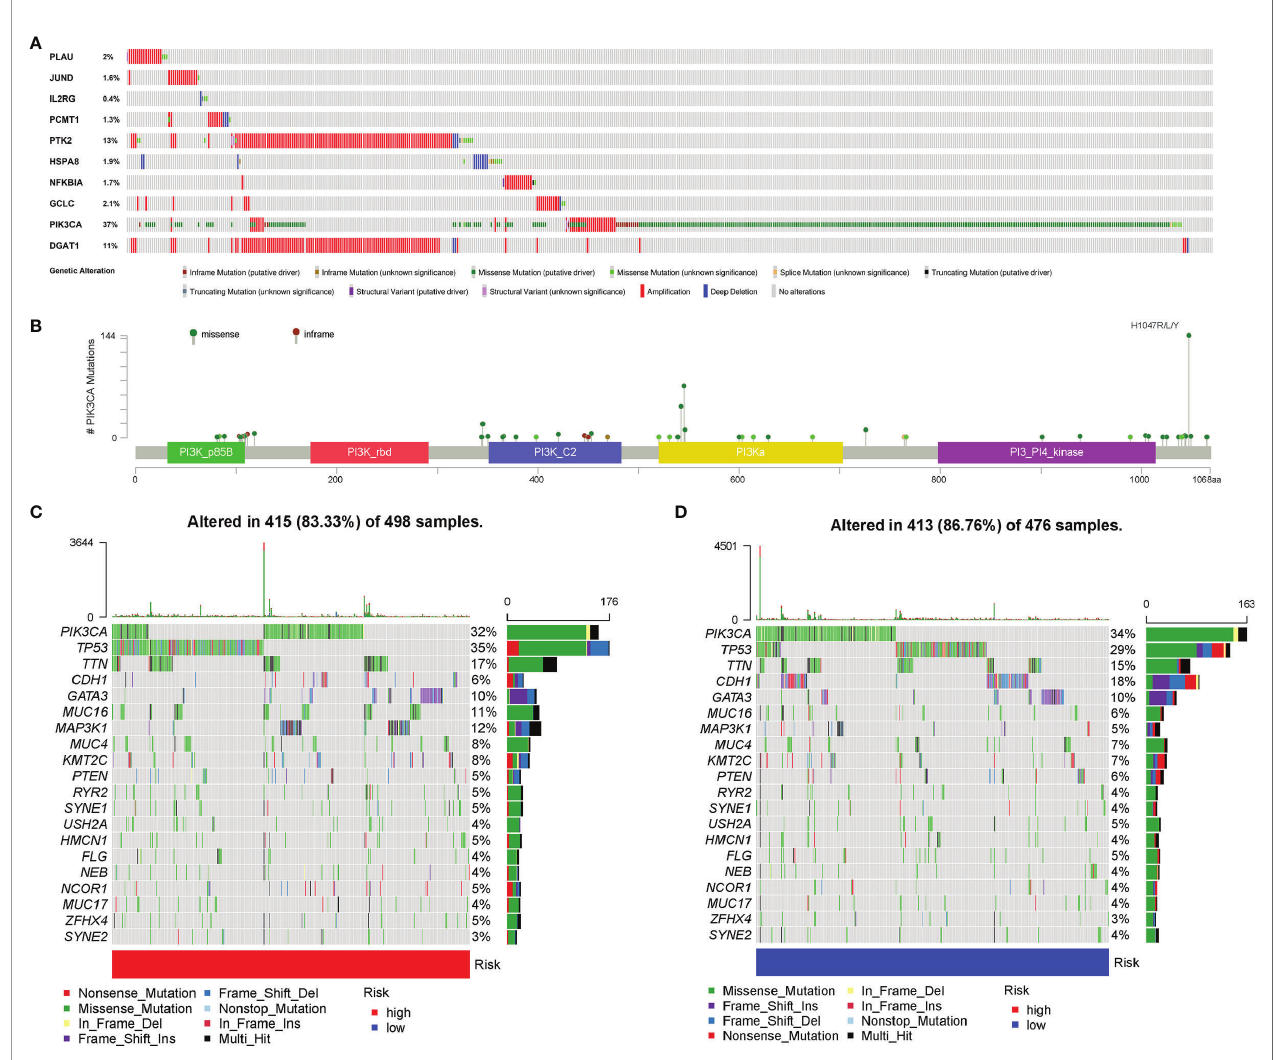
FIGURE 8 | Genetic alteration of aging-related genes (AGs). (A) The analysis about the mutation status of the 10 AGs in our risk model. (B) The most frequent genetic alteration of PIK3CA was missense mutation and ampli fi cation. (C) The mutation frequency and classi fi cation of the fi rst 20 gene mutations in the high-risk group. (D) The mutation frequency and classi fi cation of the fi rst 20 gene mutations in the low-risk